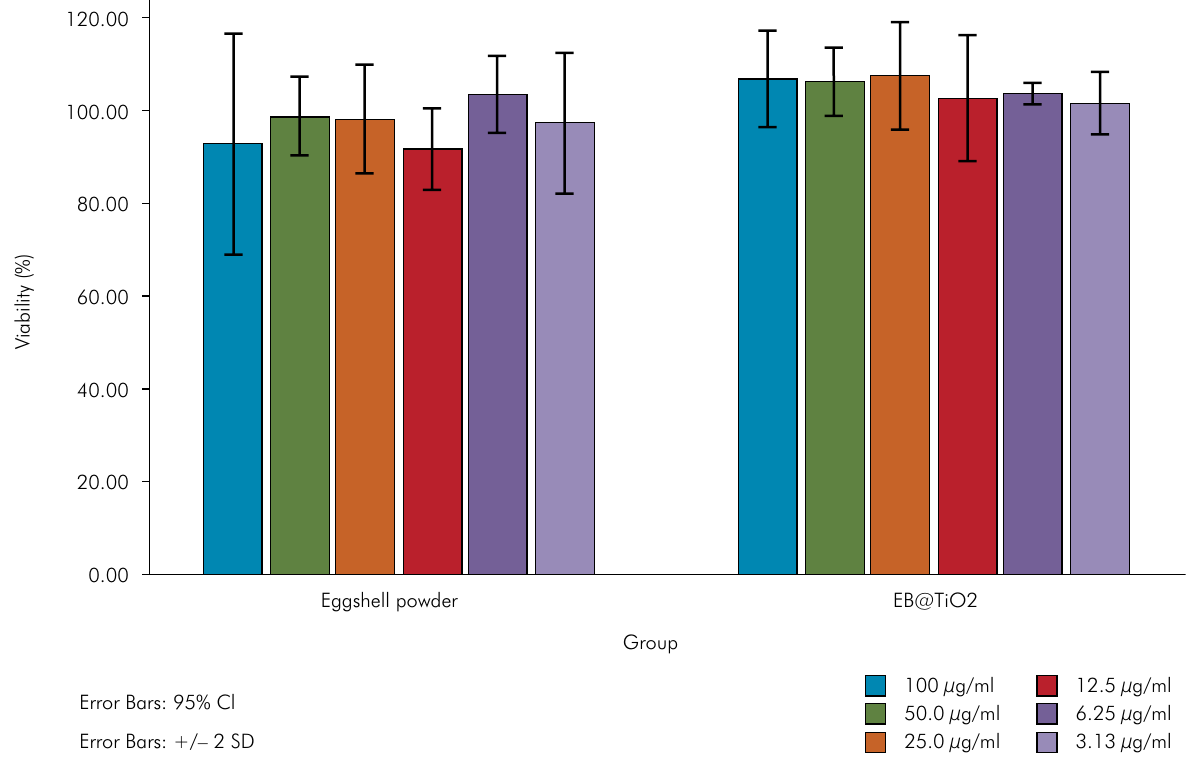
Figure 3. Percentage cell viability.